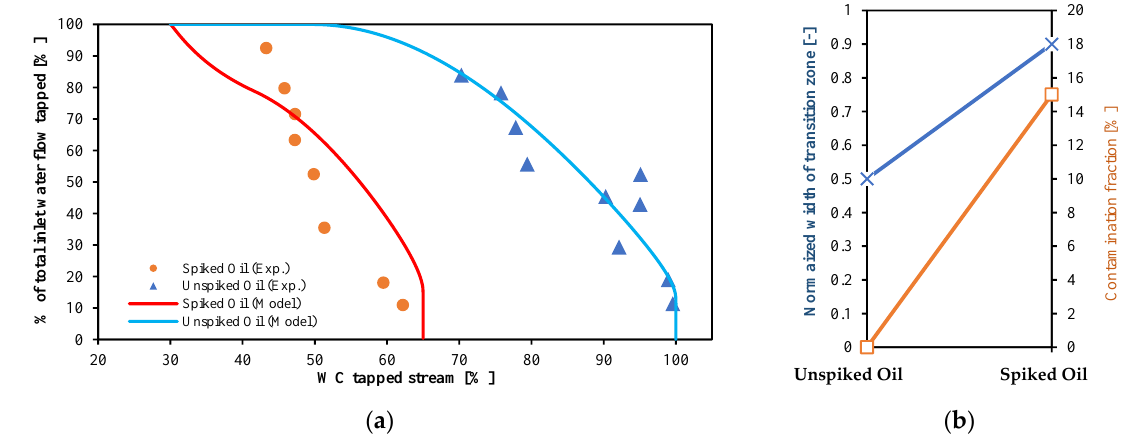
Figure 19. ( a ) Comparison between model prediction and experimental data for spiked and unspiked oils with WC inlet 30% and total flow rate 700 L/min, ( b ) normalized width of transition zone (blue line) and contamination fraction (orange line) for spiked and unspiked oil